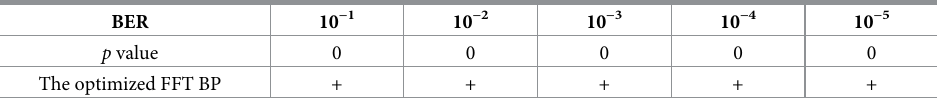
Table 1. Results of convergence comparisons at different BER by utilizing Wilcoxon rank test ( α = 0.05). BER 10 − 1 10 − 2